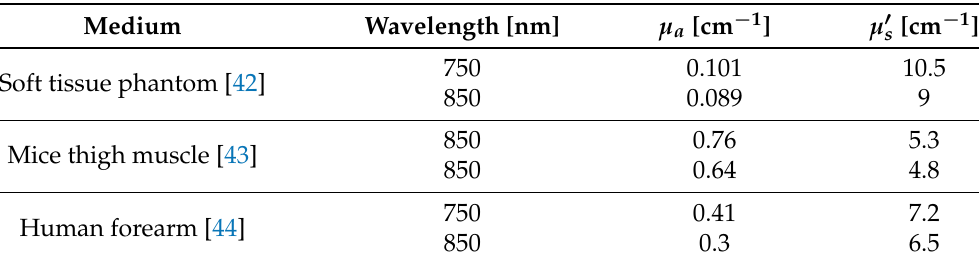
Table 1. Optical properties used in the simulations, optical absorption coefficient ( µ a ) and reduced scattering coefficient ( µ (cid:48) s ) (anisotropy, g =